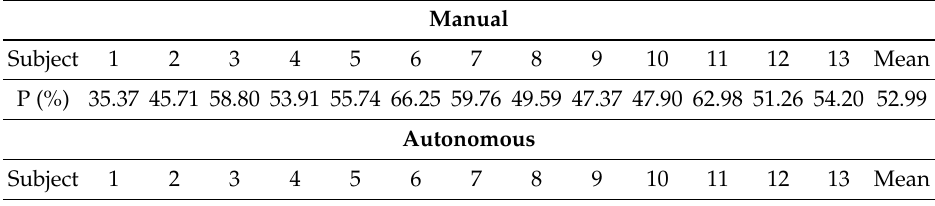
Table 2. Total number of “Stress” intervals (in %) in manual and autonomous drive.